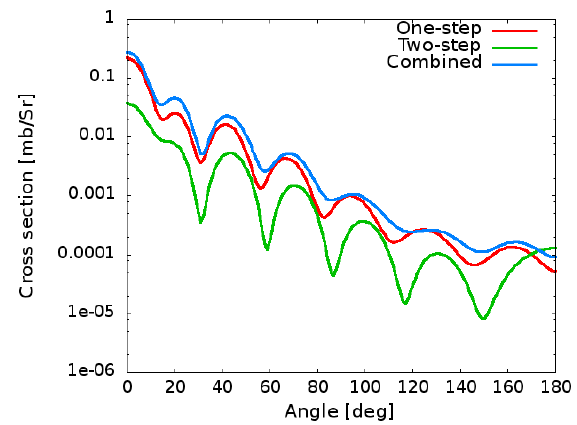
Figure 6. Comparison of the predicted triton angular distribution for the one-step, two-step, and combined model